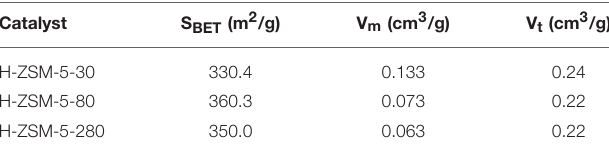
TABLE 1 | Parameters based on the N 2 adsorption measurements of the pure H-ZSM-5 zeolites with different SiO 2 :Al 2 O 3 ratio.